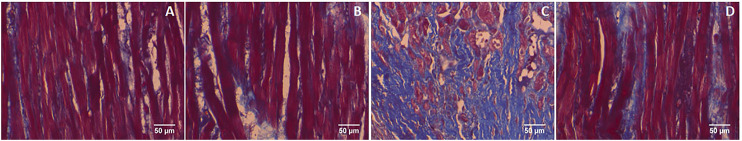
Histopathology of heart tissue stained with Masson's trichrome (40×). (A) Control rat shows a normal distribution of collagen. (B) GA alone treated rat shows a normal distribution of collagen. (C) ISO-control rat shows interstitial collagen accumulation (blue colour). (D) Pretreatment with GA showed reduced interstitial collagen accumulation.